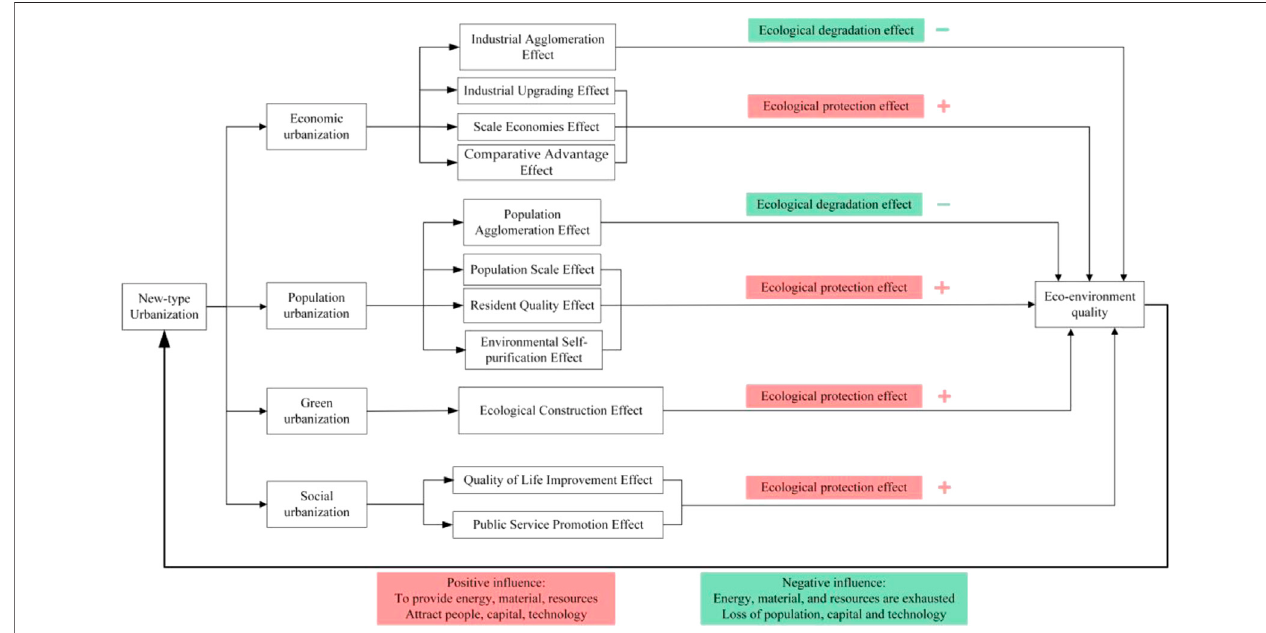
FIGURE 3 | Coupling mechanism diagram of new-type urbanization and ecological